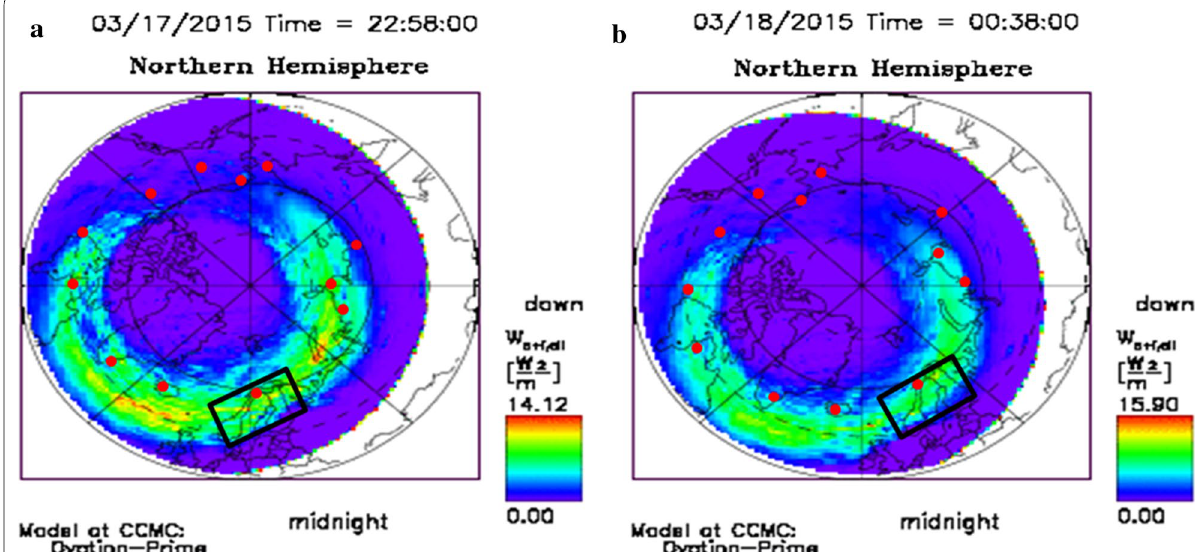
Fig. 3 Polar grid plots of the electron and ion fluxes output of the Ovation-Prime model at a 22:58 UT on 17 March 2015 and at b 00:38 UT on 18 March 2015. Spatial distributions of the 12 standard AE stations are marked with red spots. Locations of magnetometer stations in the Fennoscandia magnetometer chain are enclosed with a black rectangle